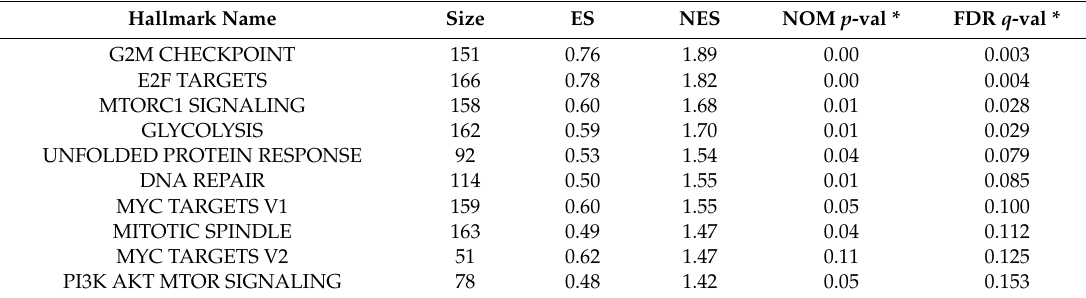
Table 3. Hallmark gene sets enriched in pre-NACT samples.